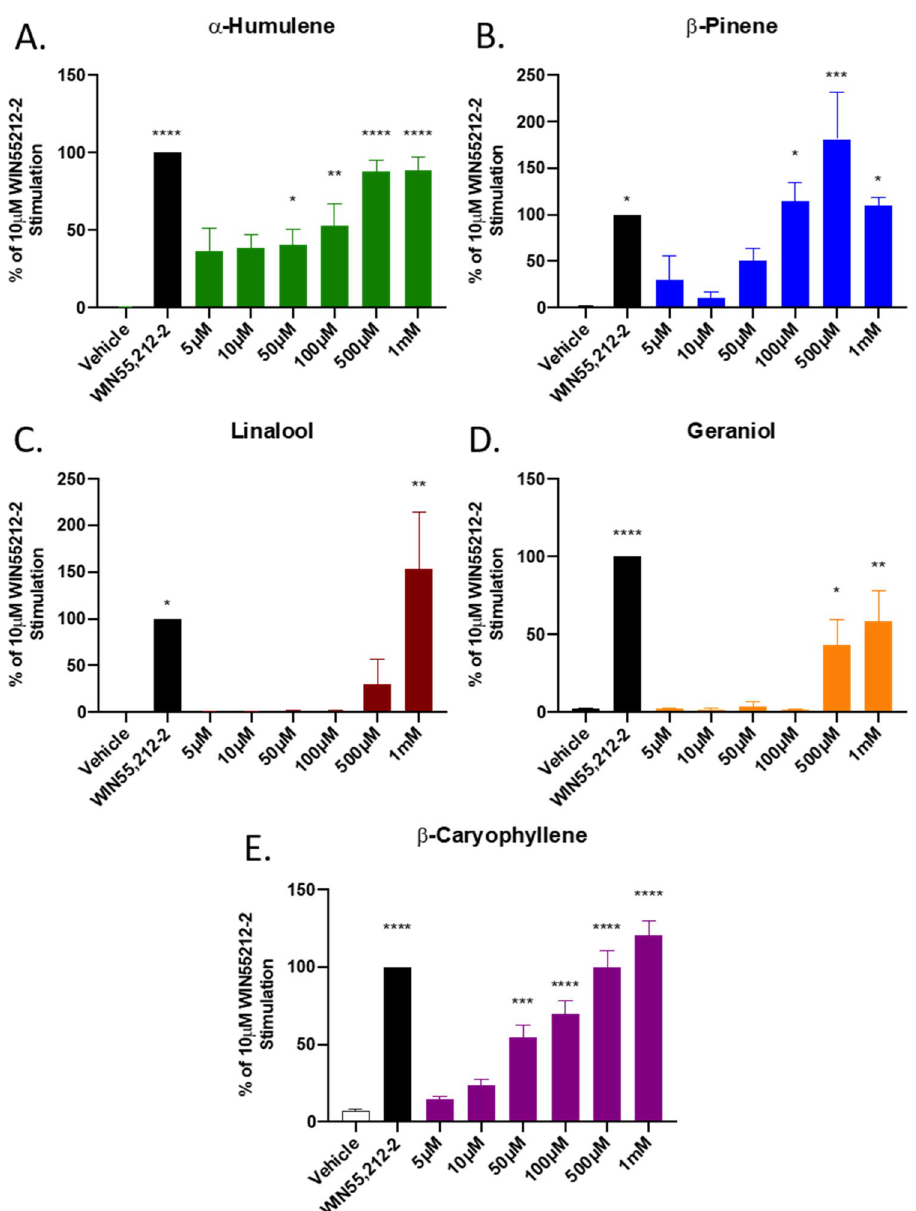
Figure 6. Terpene Treatment Activates the CB1 In Vitro. CB1-CHO cells were serum starved for 1 h then treated with varying concentrations of ( A ) α-Humulene, ( B ) β-Pinene, ( C ) Linalool, ( D ) Geraniol, ( E ) β-Caryophyllene, along with 10 μM WIN55,212-2 positive control or matched vehicle control, for 5 min. Lysates were then subjected to Western analysis and blotted for phospho-ERK and total-ERK (see Methods). Graph represents the quantified Western bands (pERK/tERK). Data expressed as a % of WIN55,212-2 stimulation (n = 3 independent experiments). Statistics analyzed via one-way ANOVA, Dunnett’s post hoc; * p <